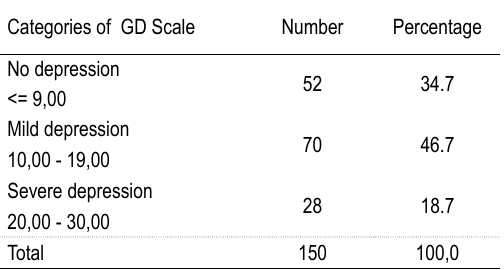
TablE 1. geriatric scale of depression evidenced on exam - inees